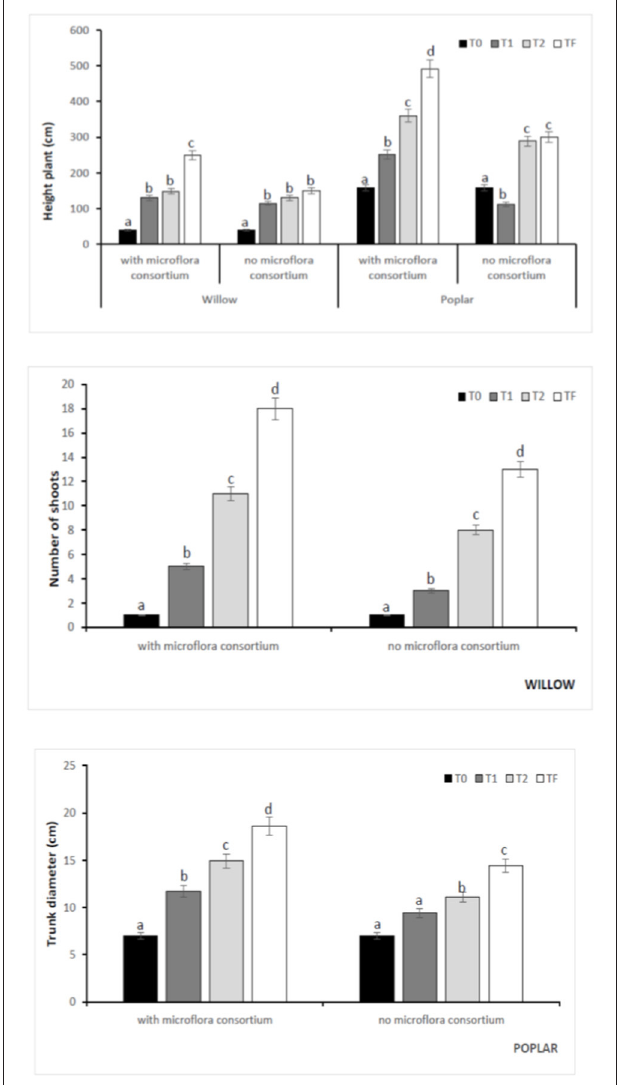
FIGURE 4 | Kinetics of the biometric parameters at different monitoring time (T 0 :0, T 1 :12, T 2 :24, and T F : 36 months) with microflora consortium and no microflora consortium in hybrid poplar Populous deltoids × Populous nigra and in willow Salix purpurea subsp. lambertiana . Mean values ±